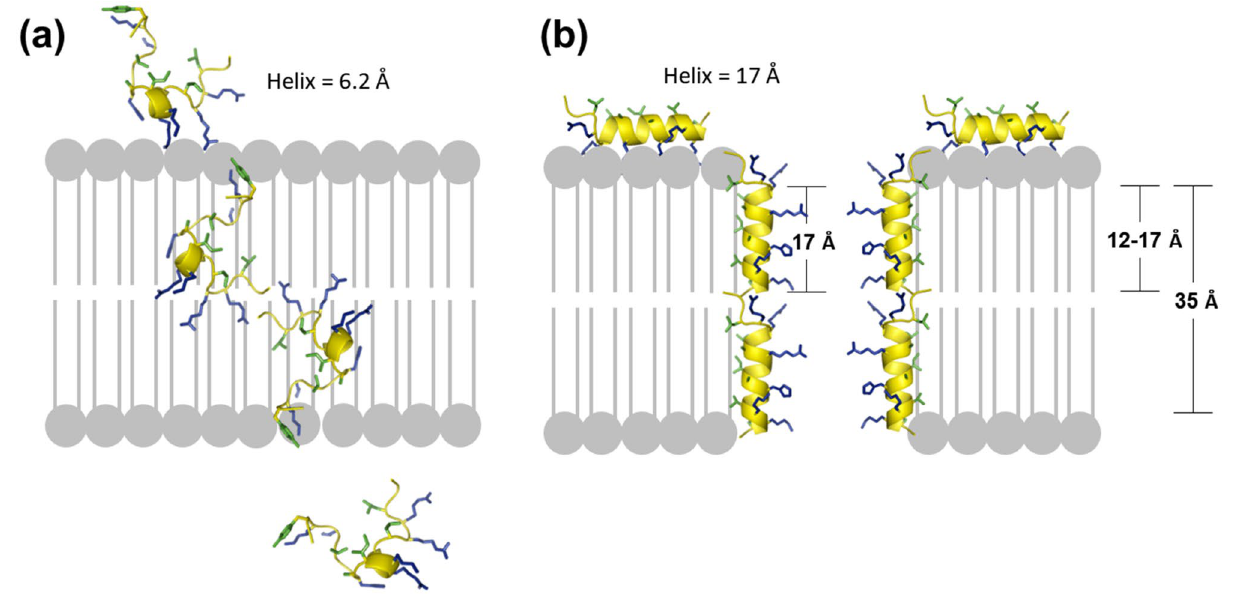
Figure 9. Schematic representation of the action of SMAP-18 ( a ) and G2,7,13A ( b ) after membrane interaction. SMAP-18 penetrates the cellular membrane without any disruption. G2,7,13A binds to the membrane lipid bilayer and change the integrity of the membrane